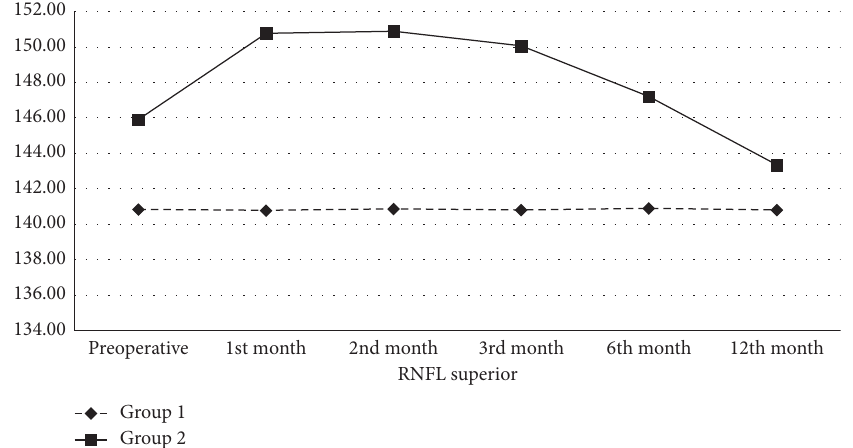
Figure 1: Retinal nerve fiber layer thickness ( μ m) change in the superior quadrant of the groups. RNFL: retinal nerve fiber layer; μ m: